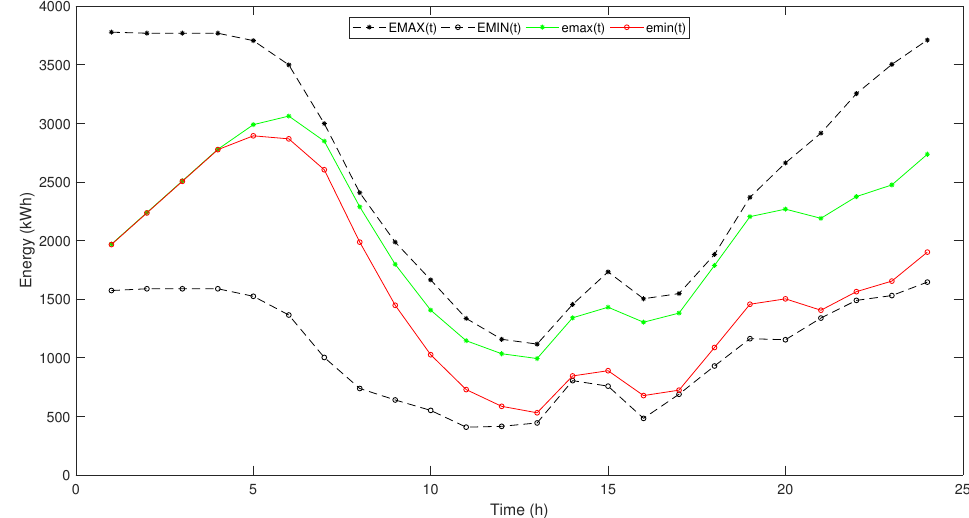
Figure 6. Evolution of bounding variables e min